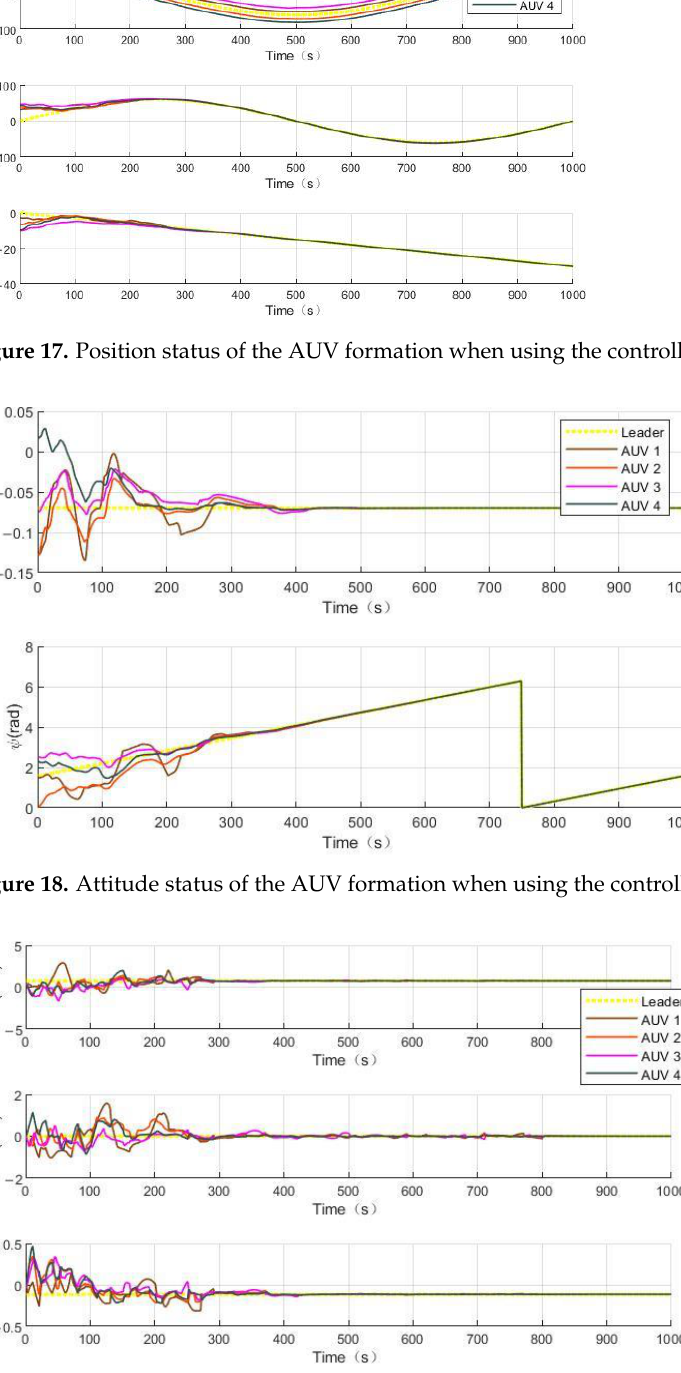
Figure 19. Linear velocity status of the AUV formation when using the controller in [13].